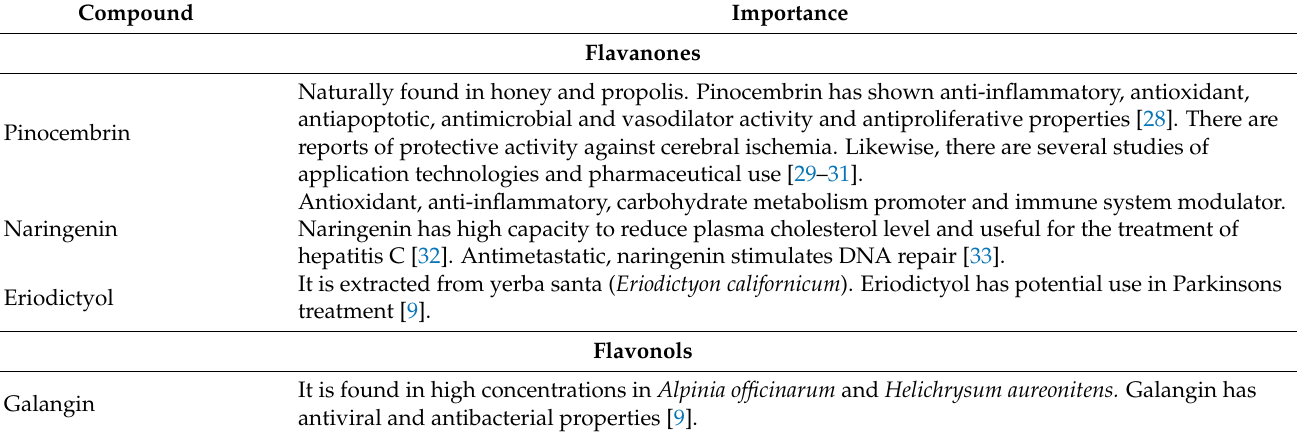
Table 4. Uses and properties of main phenolic compounds found in Mexican oregano extracts from different regions of Jalisco